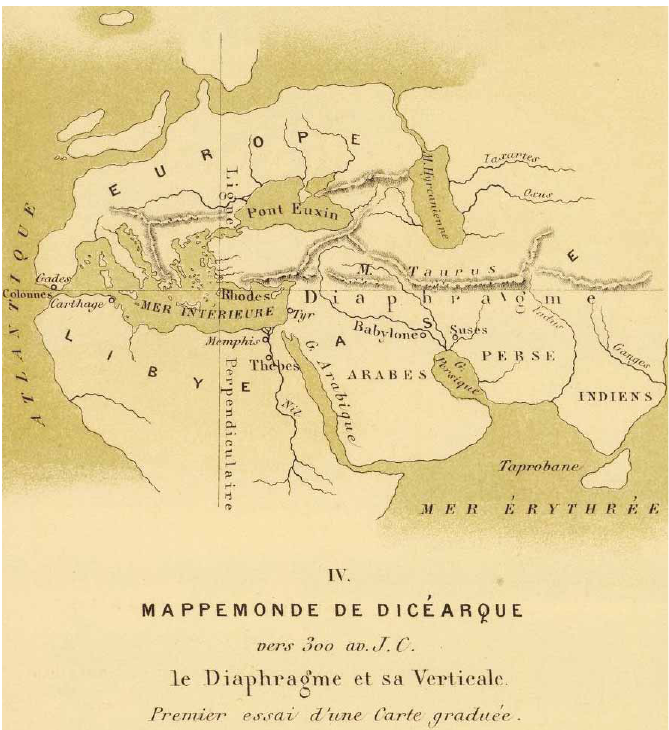
Fig. 2. Mappa mundi by Dicaearchus (from Rumsey Map Collection 2009)